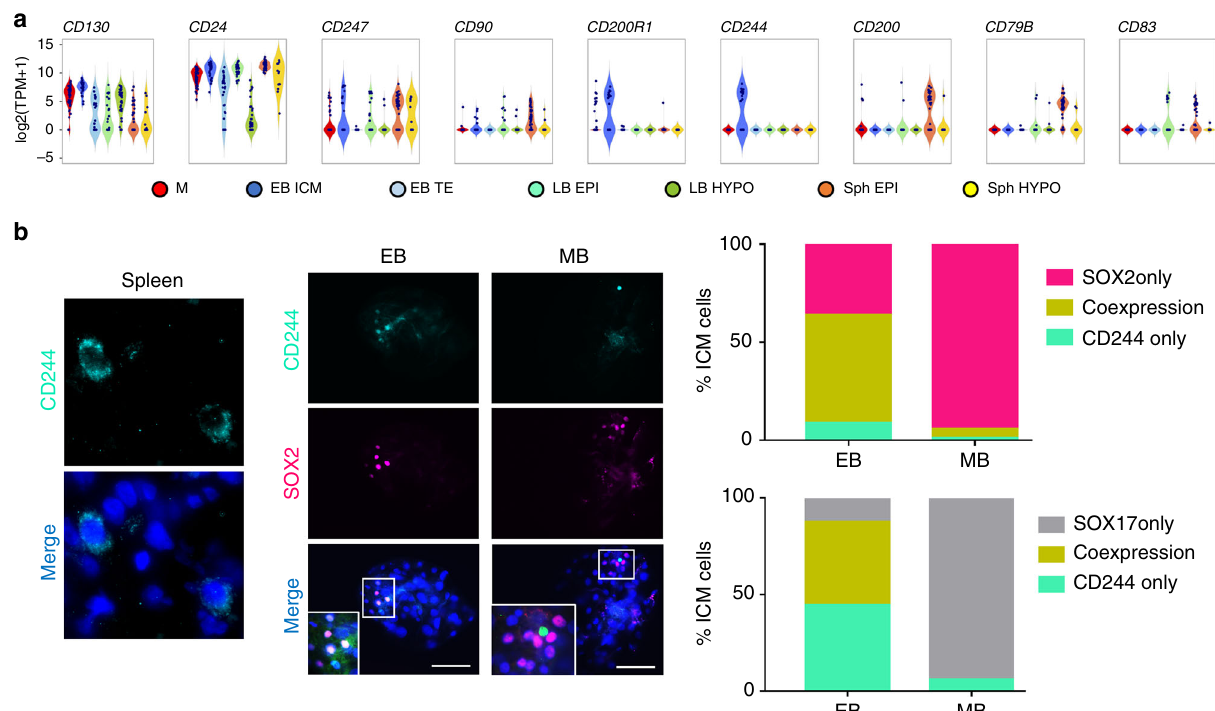
Fig. 6 Surface markers of pig pluripotent cells. a Expression of surface markers in pluripotent lineages. b IF analysis of CD244 in spleen macrophages (positive control) and in early-(EB, n = 12) and mid-blastocysts (MB, n = 5) (scale bar: 10 µ m in spleen; 100 µ m in embryos). Bar charts showing the proportion of cells within the ICM expressing CD244 only, SOX2 only, and SOX17 only or co-expressing these markers. M: morula, EB: early blastocyst, LB: late blastocyst, Sph: spherical embryo, EPI: epiblast, HYPO: hypoblast, ICM: inner cell mass, TE: